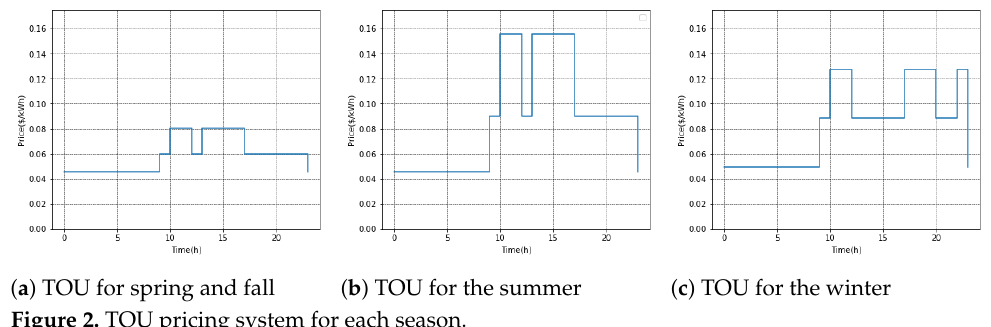
Figure 2. TOU pricing system for each season.